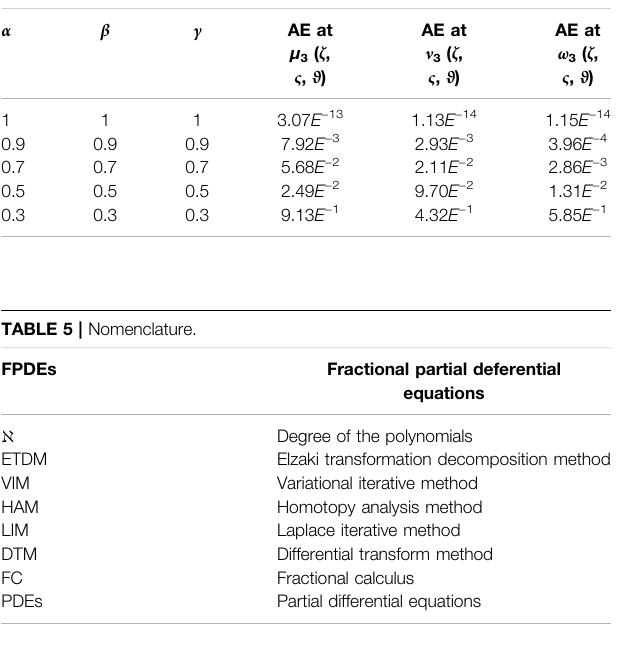
TABLE 4 | AE of ETDM at different fractional orders α , β and γ